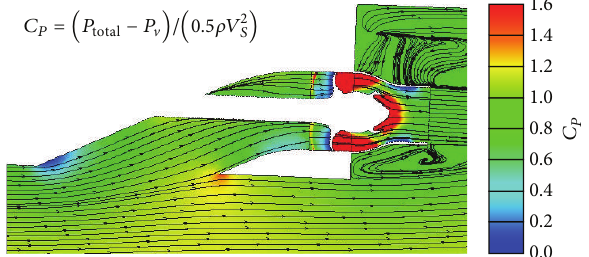
Figure 10: Pressure coefficient contours and velocity streamlines across the centerline of the waterjet system.